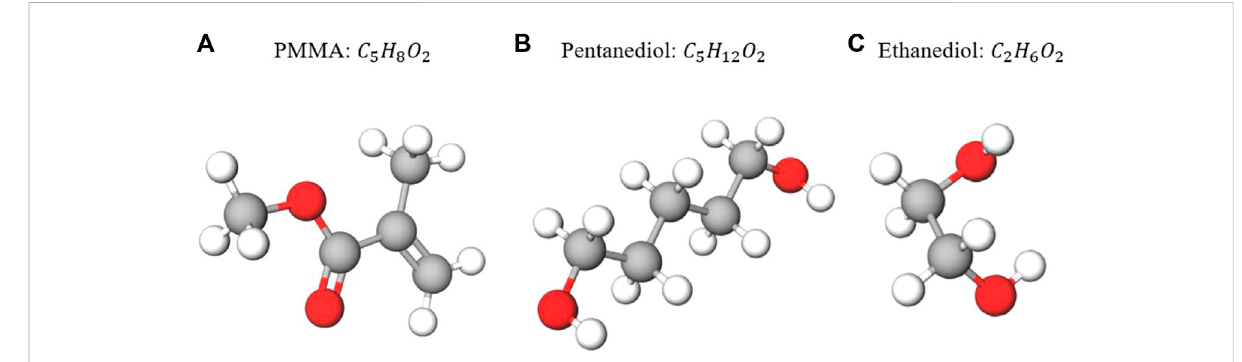
FIGURE 1 Chemical formulas and basic molecular structures of the three targets investigated in our feasibility study. The white spheres represent hydrogenatoms,theredspheres representoxygenatoms,andthegrayspheresrepresentcarbonatoms.From (A – C) :PMMA( C 5 H 8 O 2 ),pentanediol ( C 5 H 12 O 2 ), and ethanediol ( C 2 H 6 O 2 ).